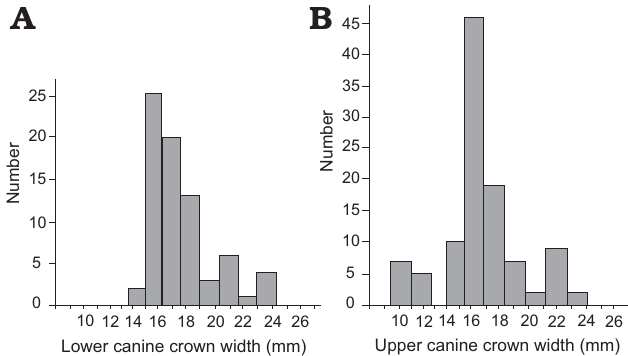
Fig. 4.Transverse diameters of all of the adult lower ( A , N = 74) and upper